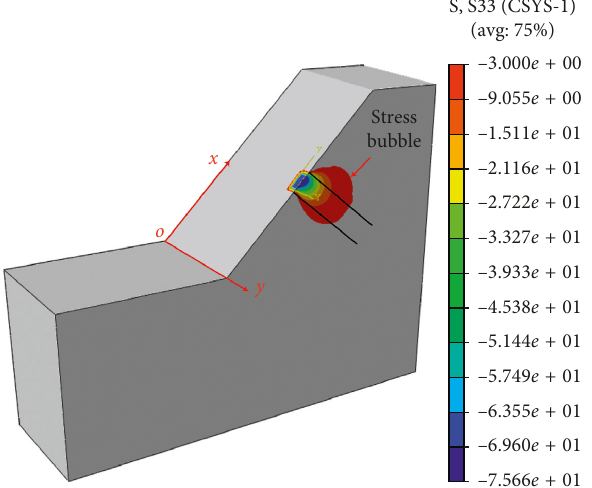
Figure 18: Additional stress contour subjected to the one lateral pressure